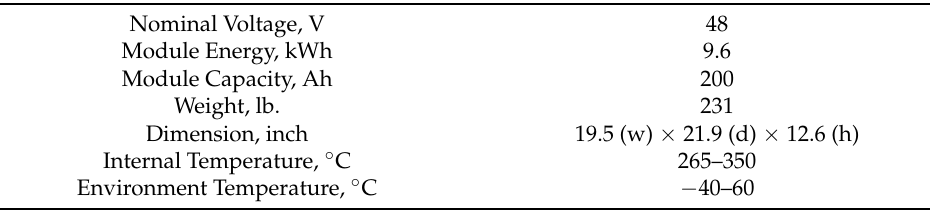
Table 1. Technical Specification of 48TL200